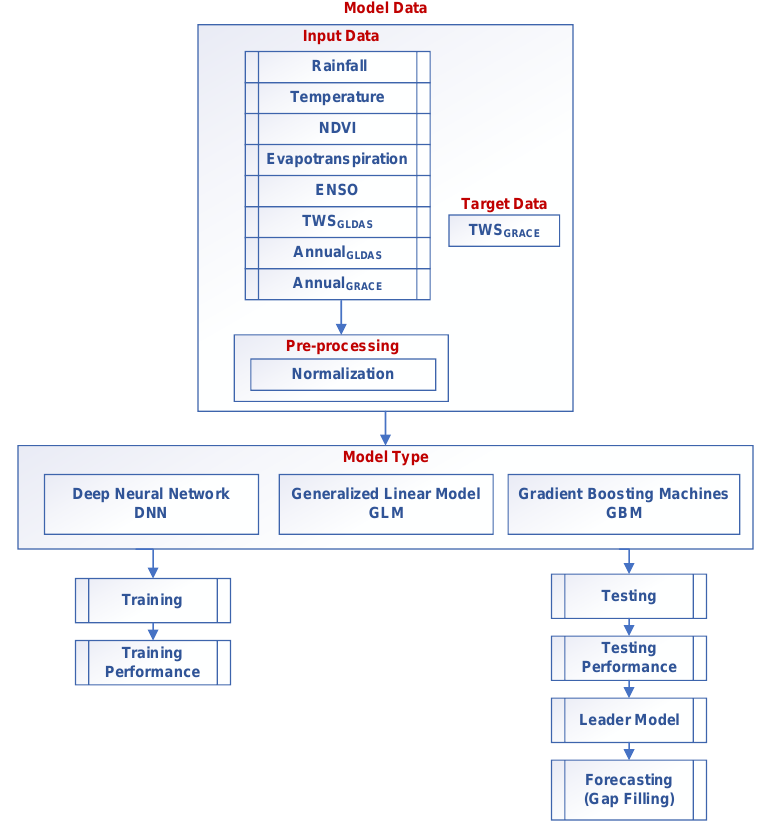
Figure 2. Flowchart showing model types, input data, and model structure used in this study.